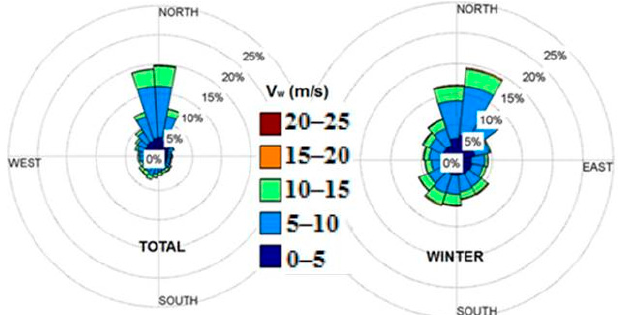
Figure 4. Analysis of the wind conditions in the vicinity of the external boundary of the local computational domain (Level III) (39.8° N, 9.75° W), corresponding to eight ‐ year model system simulations